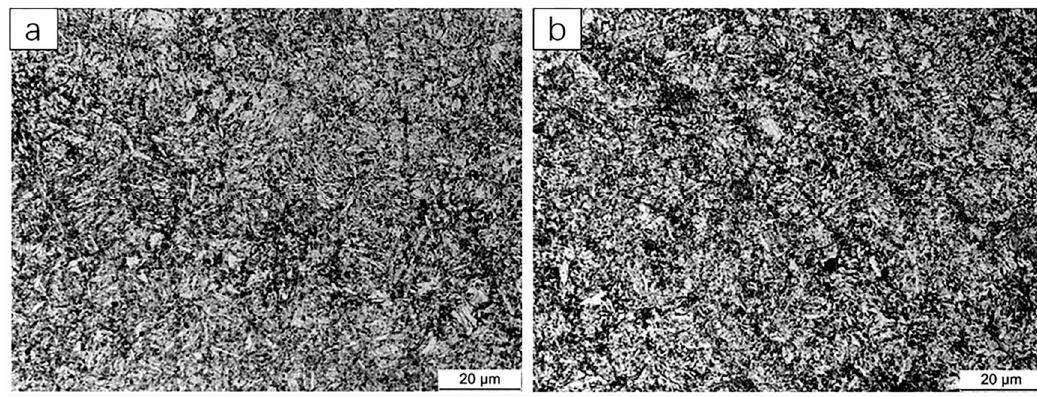
Figure 11. ( a ) 20CrMnTi 1 microstructure and ( b ) 20CrMnTi 2 microstructure.